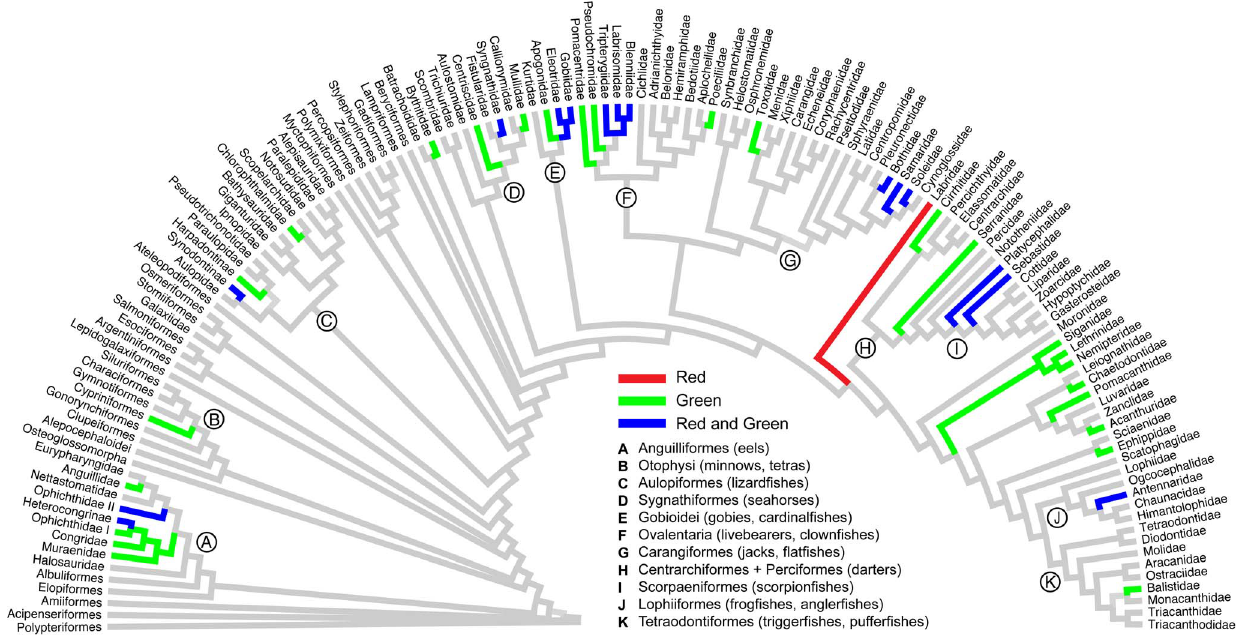
Figure 2. Observed occurrences of green and red fluorescent emissions indicate the evolution of biofluorescence is widespread across the evolutionary history of ray-finned fishes (Actinopterygii). Family-level tree showing evolutionary relationships of ray-finned fishes inferred from maximum likelihood analysis of 221 species and six (one mitochondrial, five nuclear) genes. Note: Not all biofluorescent lineages are shown due to sampling limitations (see Table S1, Fig.